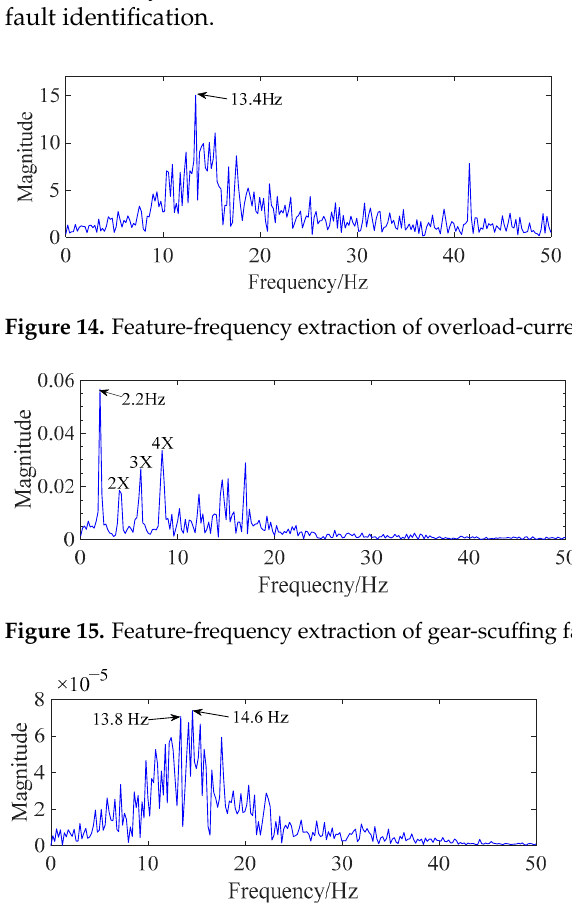
Figure 16. Overload-current fault result extracted by EMD.